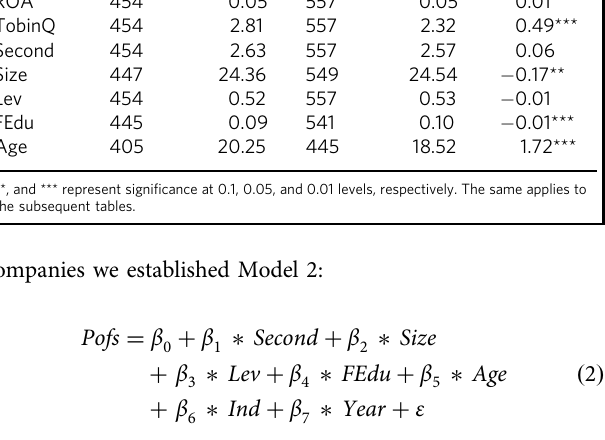
represents the two-child policy, and Ind and Year represent fi xed industries and years, respectively. Model 2 shows the impact of the two-child policy on female employment. We assumed that the two-child policy would reduce the employment of female employees. If the β 1 value in the regression results is negative and signi fi cant, H2 is accepted.